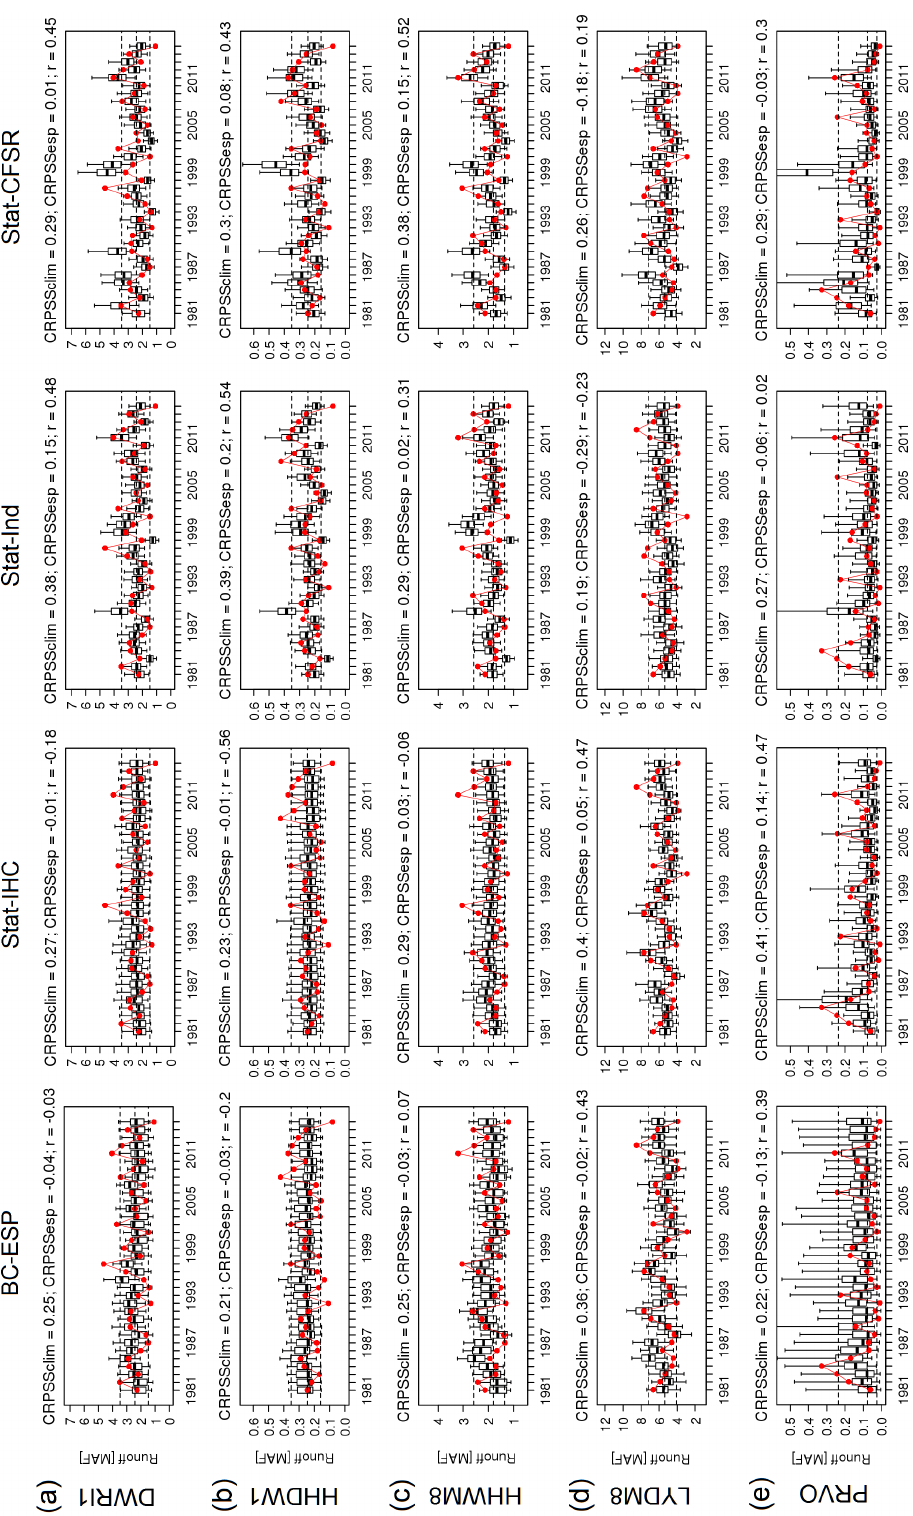
Figure 9. Time series with cross-validated hindcasts initialized on 1 December, obtained with two watershed-based methods (BC-ESP and Stat-IHC) and two climate-based techniques (Stat-Ind and Stat-CFSR) for the five case study locations (a–e) . The verification metrics CRPSS clim and CRPSS esp denote continuous ranked probability skill scores using the mean climatology and raw ESP output as the reference, respectively. Black dashed lines represent 10, 50, and 90% flows from the observed climatology, and boxplots show the 10th, 30th, 50th, 70th, and 90th hindcast percentiles. The red line represents the observed flow